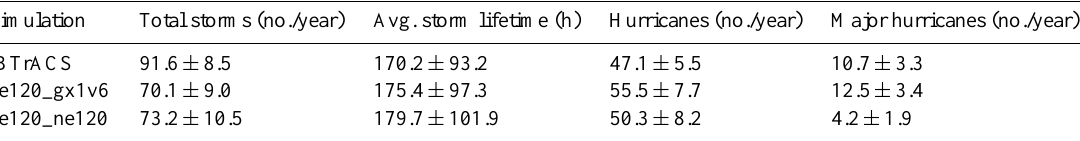
Table 1. Annual frequency of global tropical cyclones that reach tropical storm (cat. 0–5), hurricane (cat. 1–5), and major hurricane (cat. 4–5) strength the CAM5 simulations and IBTrACS observations for the time period of 1980 to 2005. The average storm lifetime is also included. The standard deviation for each variable over the sampling period is used as an estimate of uncertainty.